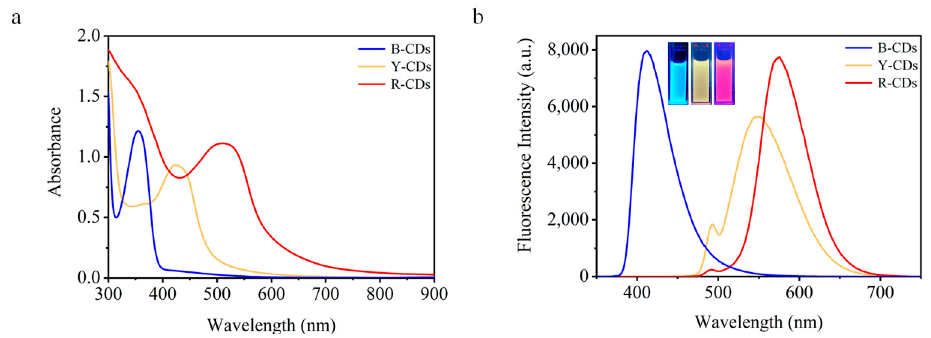
Figure 4. ( a ) The UV–vis absorption, ( b ) Fluorescence emission spectra of MCDs.